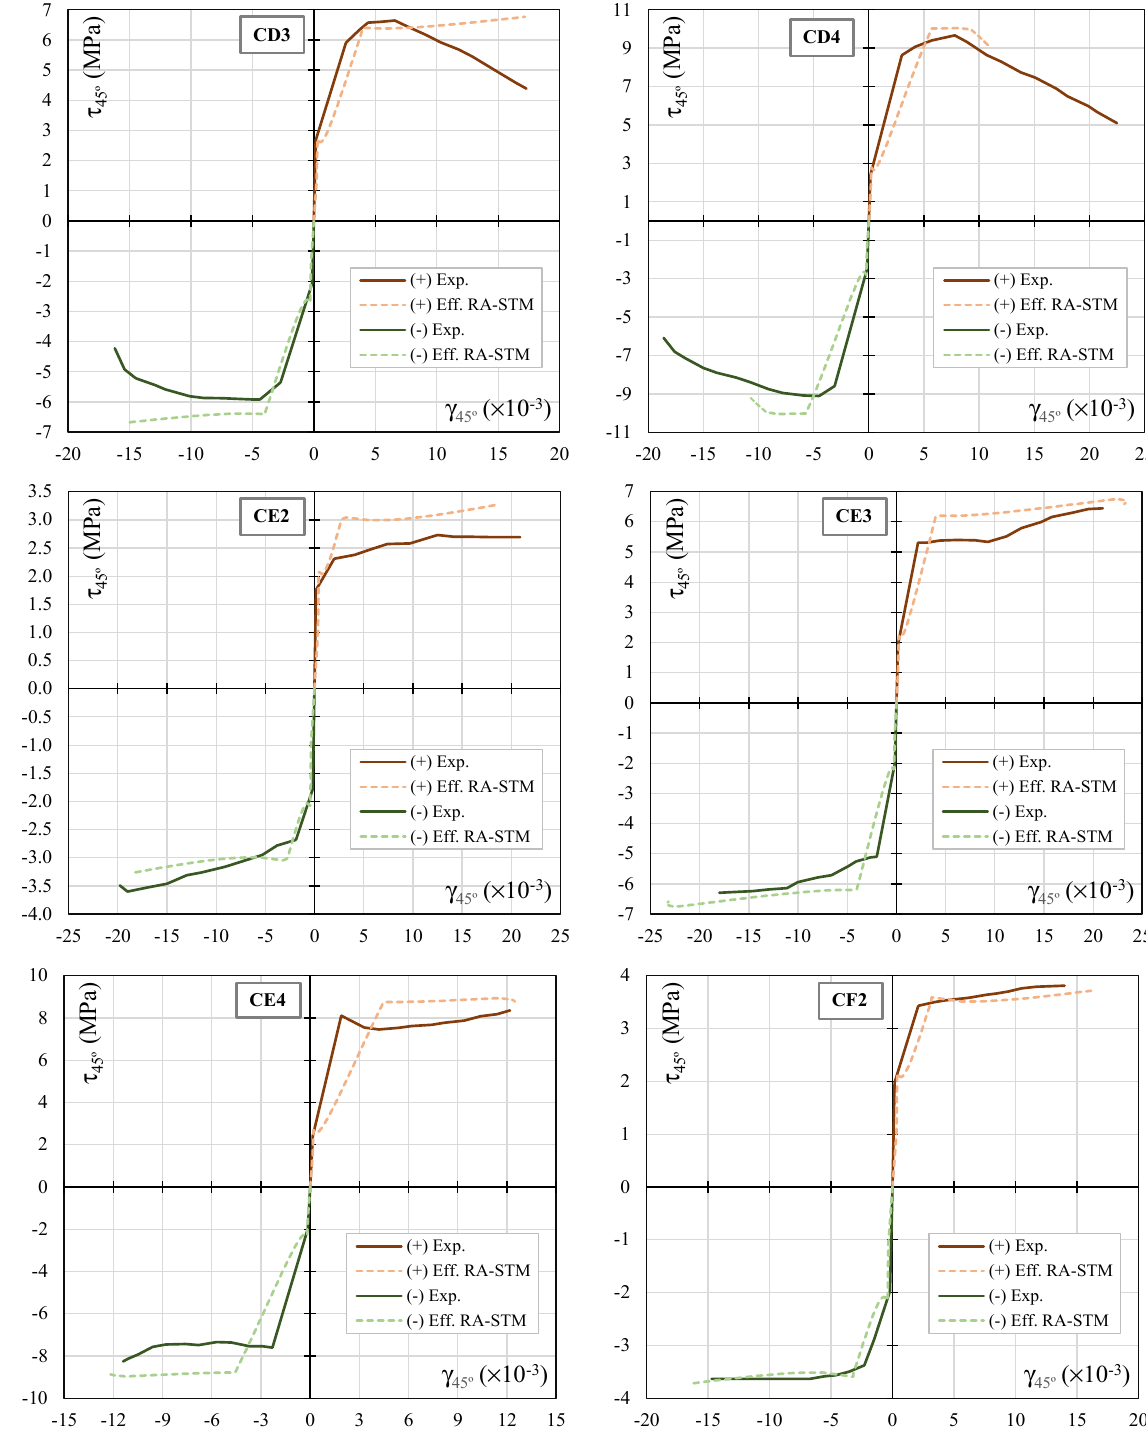
τ γ − curves for the reference RC panels (CA2, CA3, CA4, CB3, CB4 and CD2). ° ° 45 45